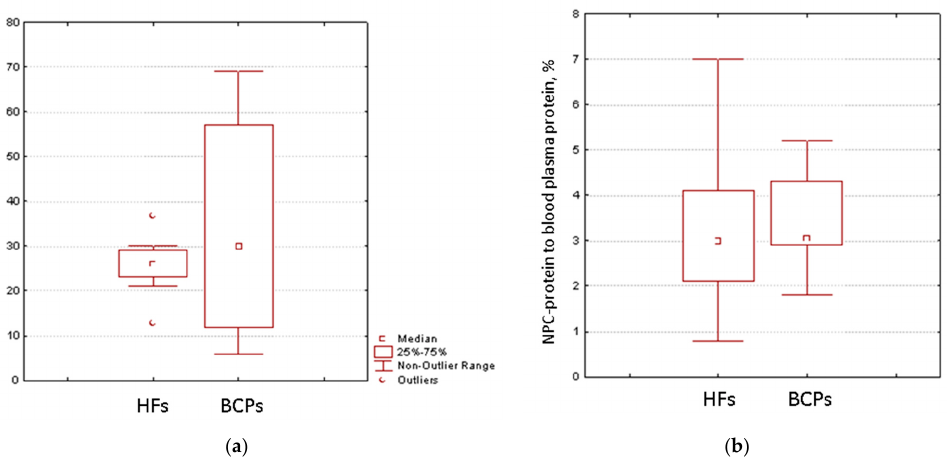
Figure 3. Characterization of NPCs circulating in the blood plasma of HFs and BCPs in terms of nucleic and protein components: ( a ) the share of DNA in NPCs versus concentration of cfDNA in blood plasma; ( b ) the share of protein in NPC versus total blood plasma protein. Tukey box plots, median concentration with 25–75%, and non-outlier range bars are indicated.